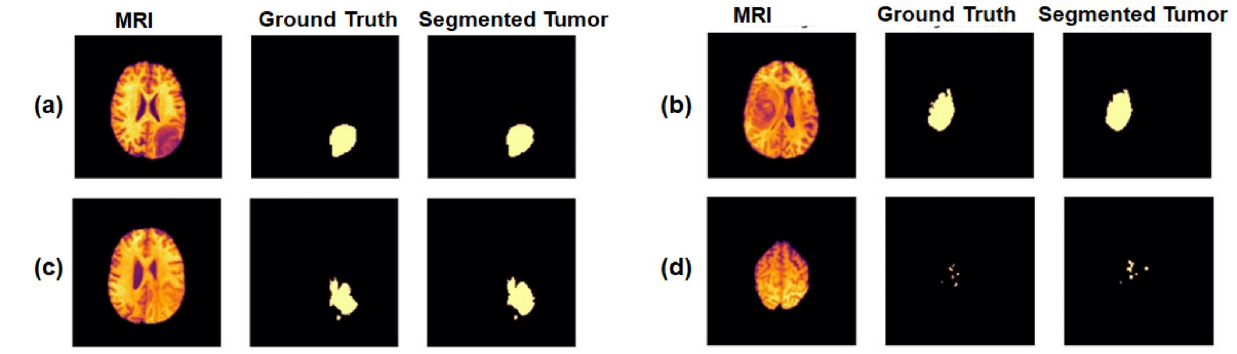
Fig 29. Sample segmentation outputs for 3D U-Net++